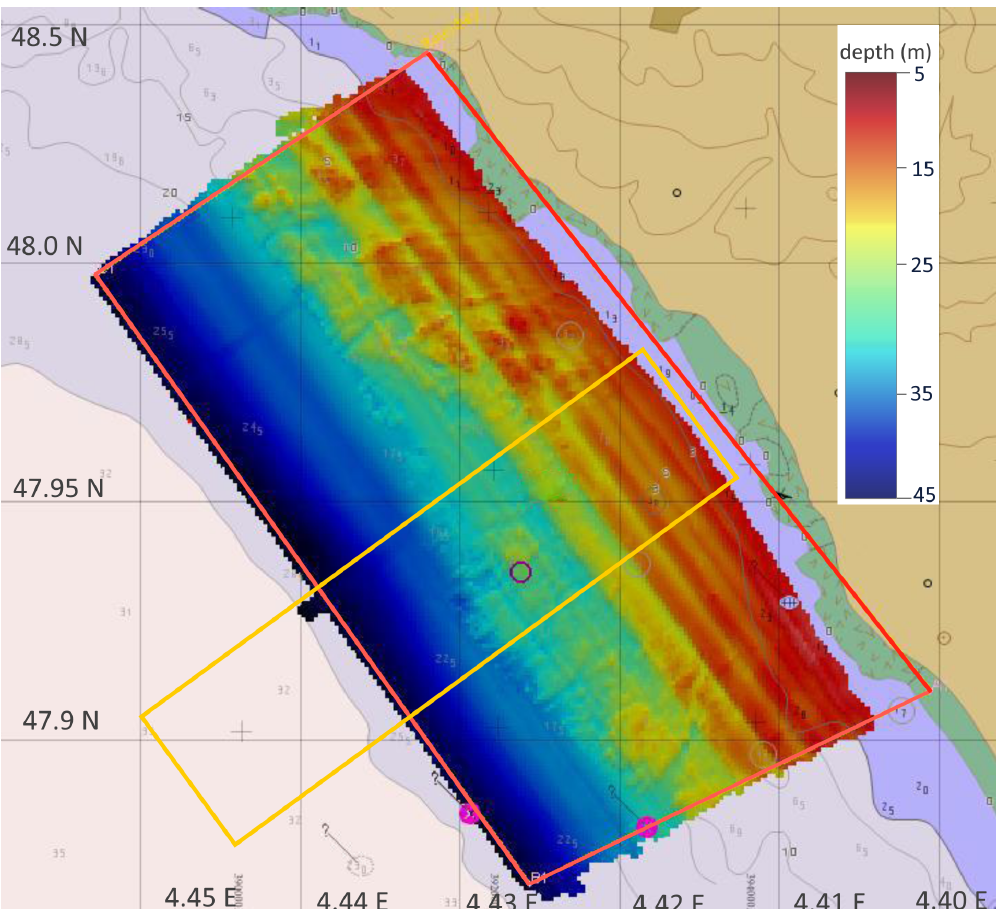
Figure 3. Map showing the detailed bathymetric survey of the project area (red box) with the present investigation domain (yellow box) overlaid [6].